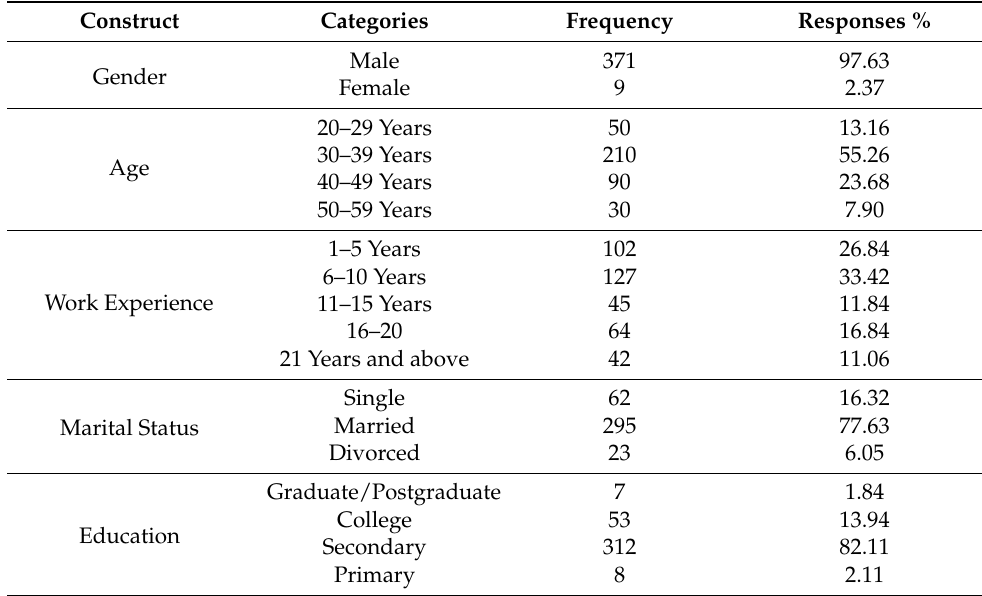
Table 2. Demographic of the Respondents (N =